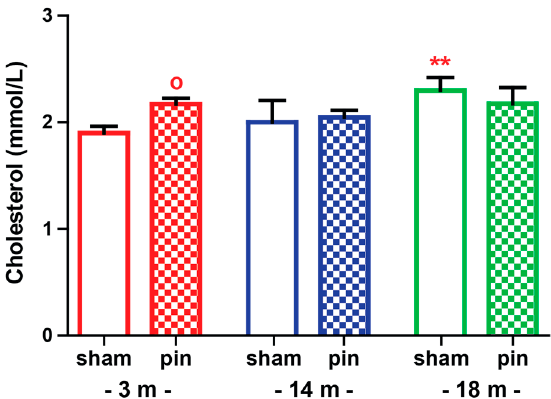
Figure 6. The effect of pin on cholesterol levels in serum of 3-, 14- and 18-month-old rats. Data are presented as mean ± S.E.M. ** p = 0.007 18-month-old sham rats compared to matched 3-month-old rats; o p = 0.0101, 14-month-old pin compared to matched sham group (A); o p = 0.023, 14-month-old pin compared to matched sham group (B); ** p = 0.0055, 14-month-old sham compared to matched 3-month-old group; 18-month-old sham compared to matched 3-month-old group; o p = 0.012, 3-month-old pin rats compared to matched sham group. 3-month-old rats—red; 14-month-old rats—blue; 18-month-old rats—green.